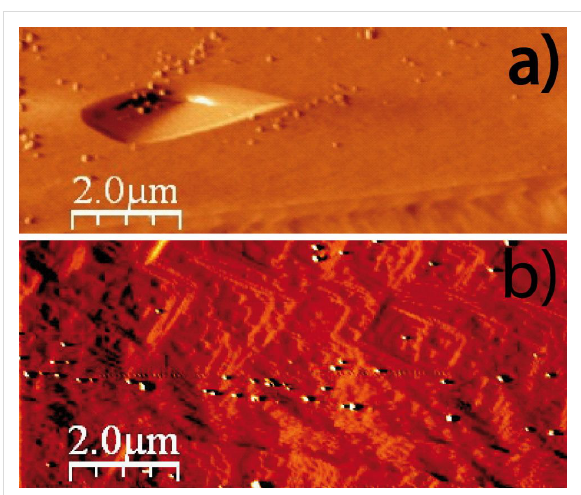
Figure 5: AFM deflection images of the reacted dolomite (104) cleavage surface in acid Na 2 SO 4 solutions: a) after 10 min in pH 2, isolated etch pits were observed and b) in pH 3, nucleation of etch pits was observed all over the surface after 8